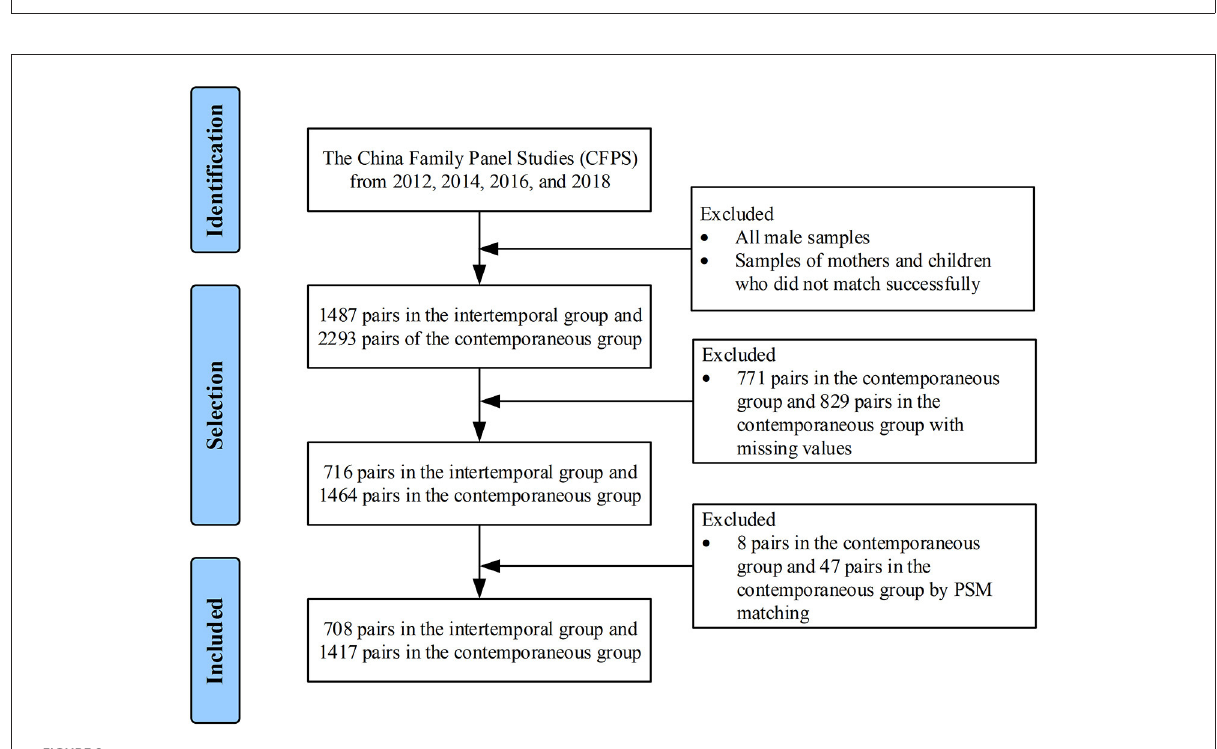
FIGURE2 Flow chart of the study participants. Data from the China Family Panel Studies (CFPS) from 2012, 2016, and 2018 were applied.